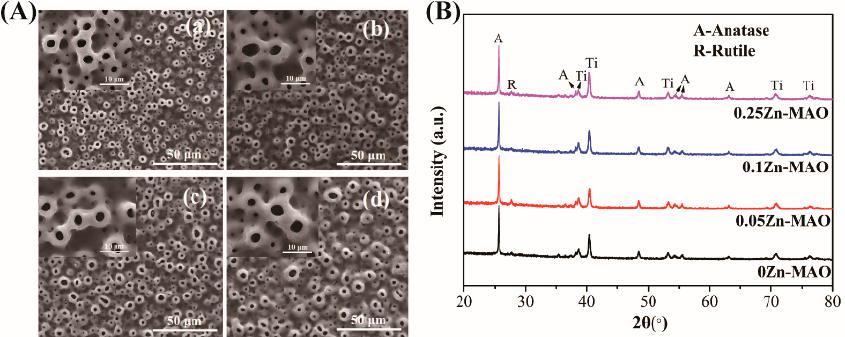
Figure 1. Surface morphologies of different coatings ( A ): ( a ) 0Zn-MAO, ( b ) 0.05Zn-MAO, ( c ) 0.1Zn- MAO, ( d ) 0.25Zn-MAO. XRD patterns of different coatings ( B ).